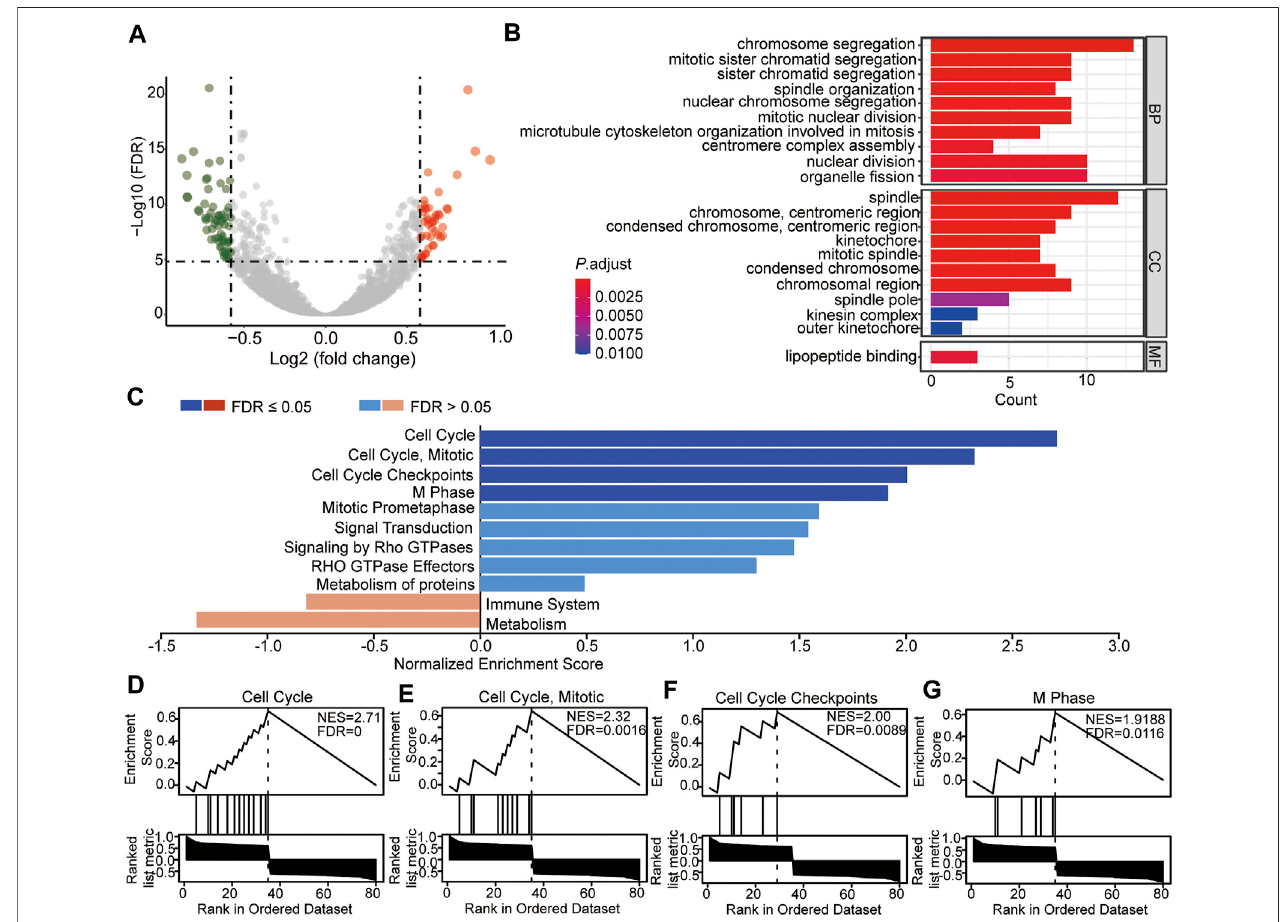
FIGURE10| Identi fi cationandenrichmentanalysisofDEGsbetweenthetworisk-subtypes. (A) VolcanoplotshowingtheDEGsinhigh-riskvs.low-riskgroups. (B) EnrichedGOtermsofDEGsinthehigh-riskgroup. (C) GSEAanalysisofDEGsinthehigh-riskgroup (D – G) GSEAenrichmentwiththethresholdofFDR < 0.05ofDEGsin the high-risk group. NES: normalized enrichment